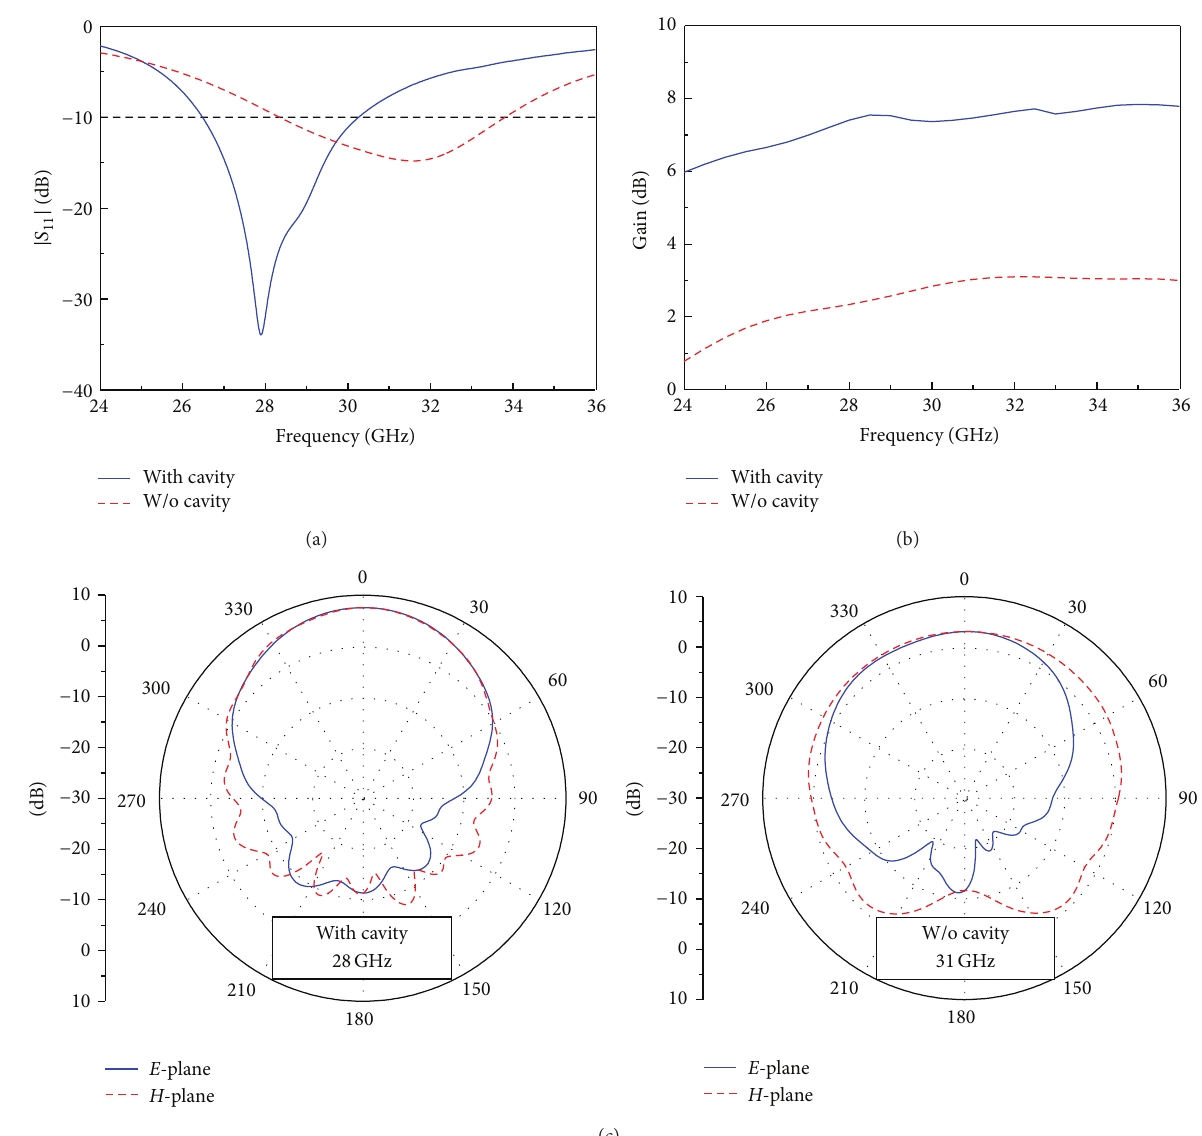
Figure 2: Performance comparison for the angled-dipole antennas with and without cavity: (a) |𝑆 11 | , (b) gain, and (c) radiation patterns.